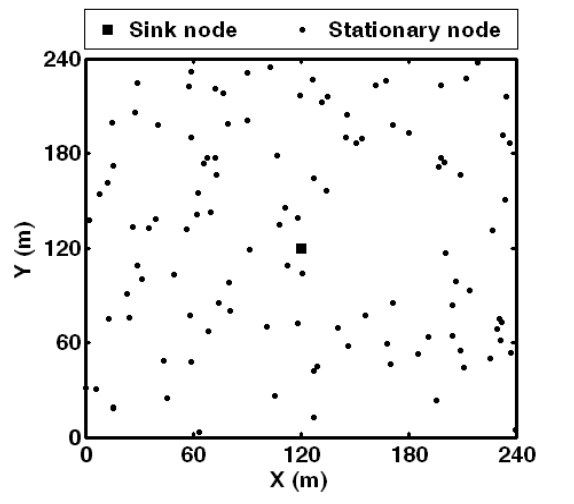
Figure 2. Initial deployment and coverage state of WSN: (a) Placement of sink node and stationary nodes; (b) Coverage state of stationary nodes in the sensing